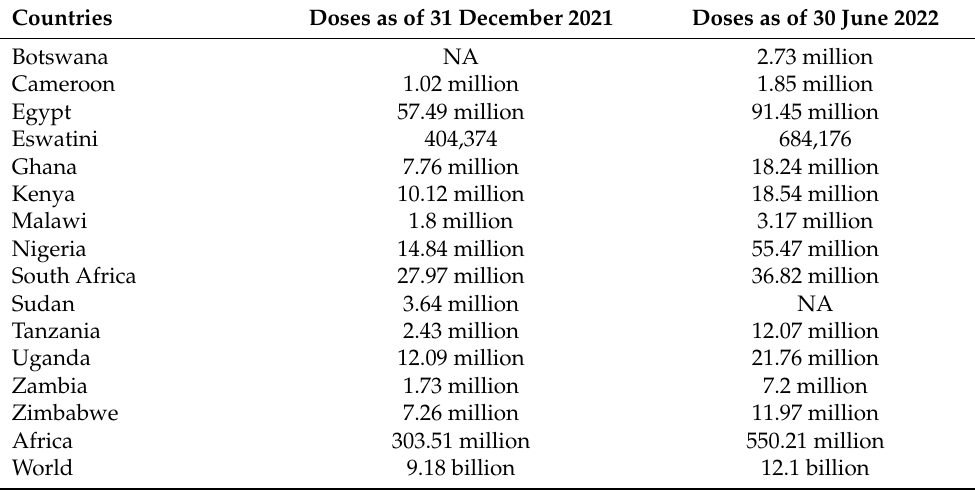
Table 3. Number of vaccine doses utilised by the countries as of 31 December 2021 and 30 June